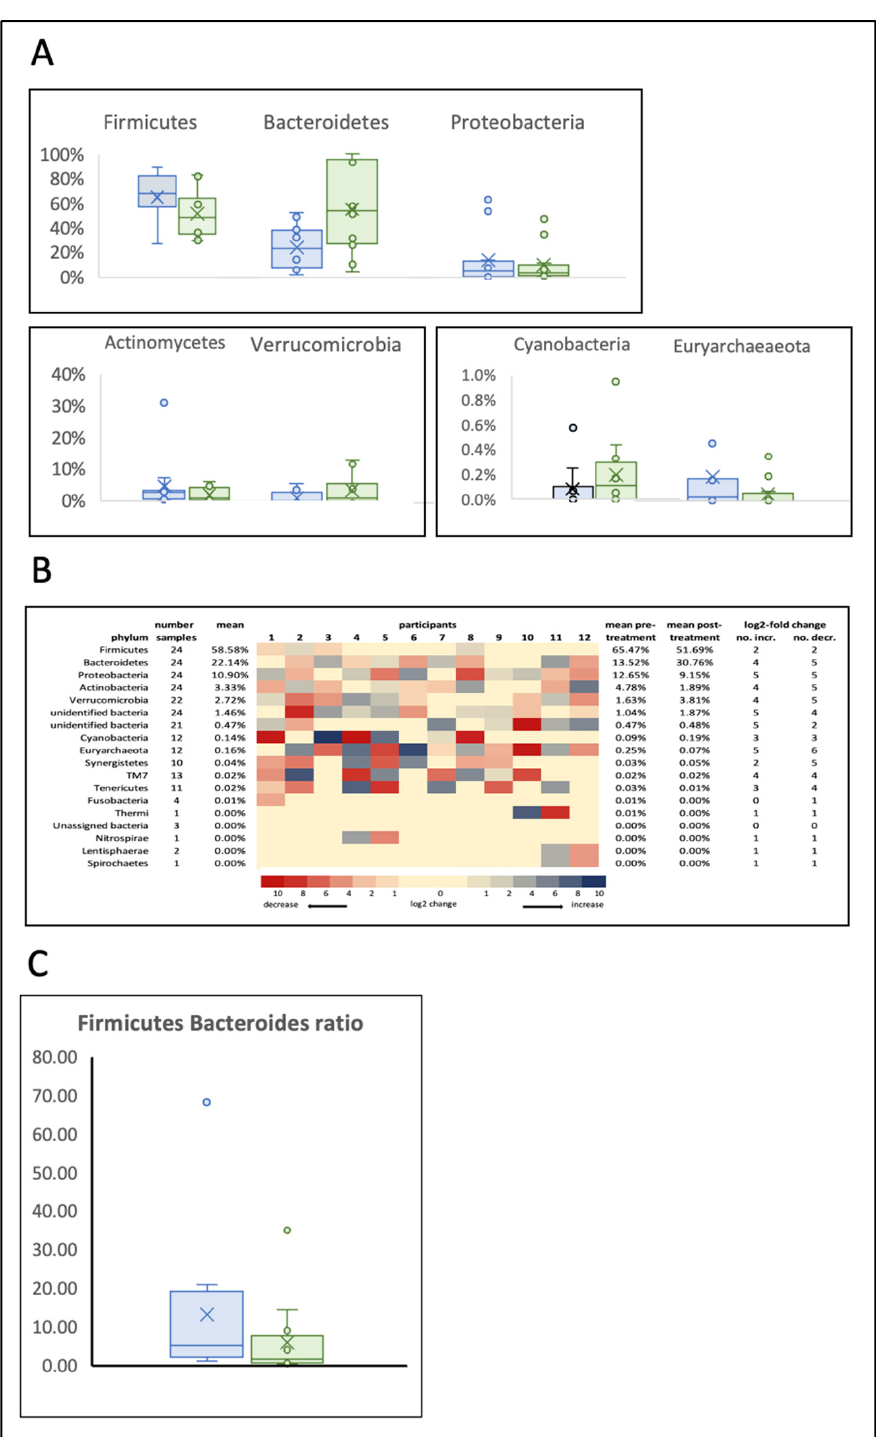
Figure 2. Changes in the abundance of phyla in the gut microbiome of PD participants after 12 weeks of treatment with PBM. ( A ) Abundance of phyla. ( B ) Heatmap of changes in phyla for individual participants. ( C ) Firmicutes:Bacteroidetes ratio.